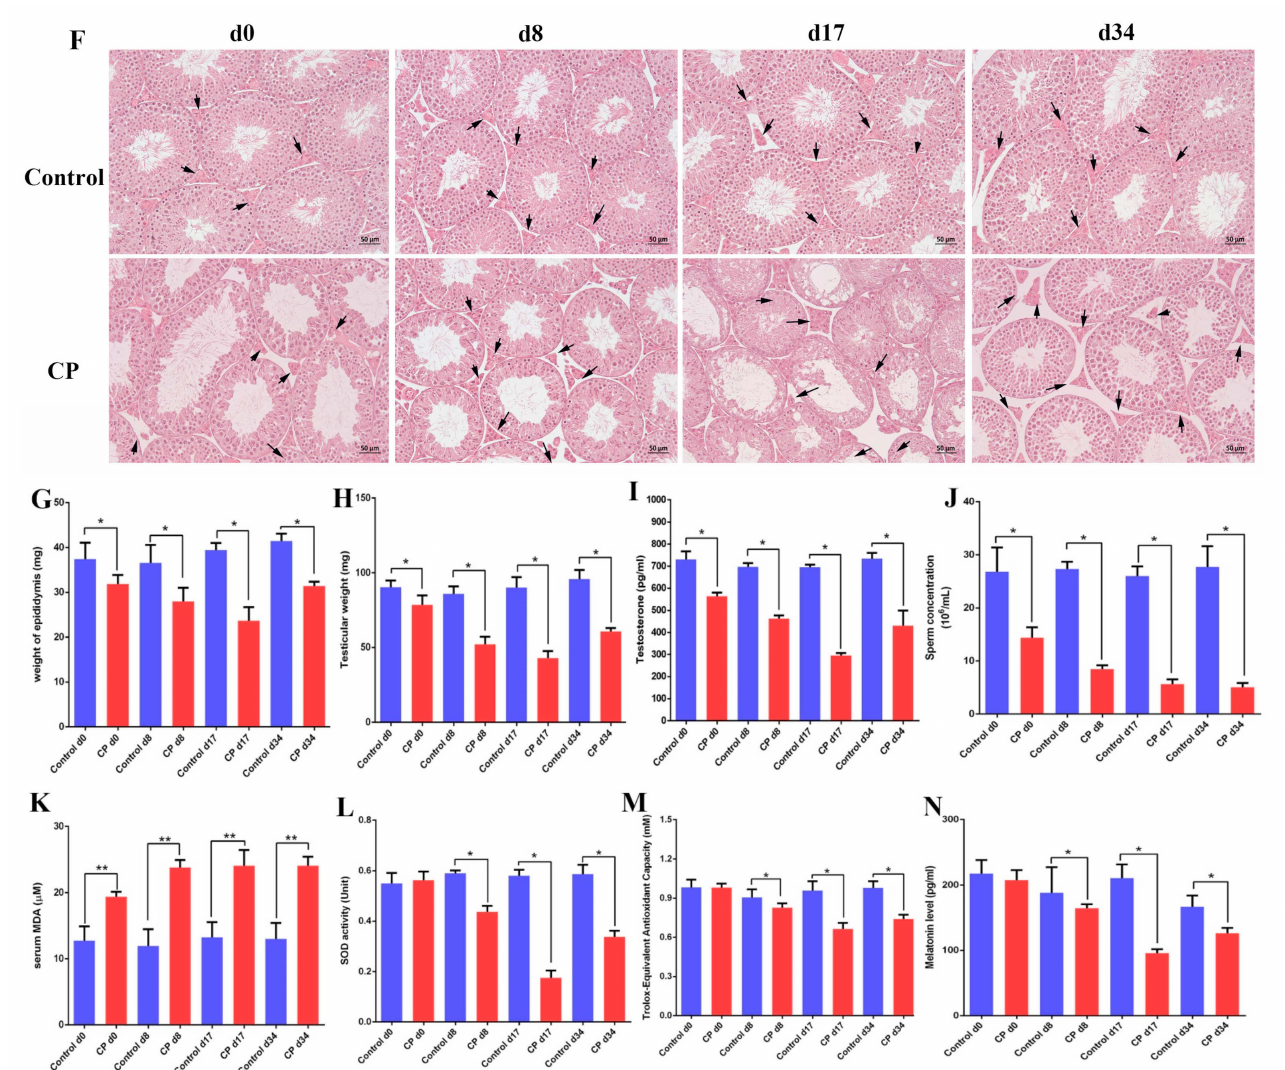
Figure 2. Cisplatin treatment resulted in damage to the testes of male mice and increased oxidative stress. ( A ) Experimental design. ( B ) Changes in the body weight of mice during different recovery periods after cisplatin treatment. ( C ) Images of mouse testes sizes. ( D ) Images of mouse epididymides sizes. ( E ) Mouse epididymides stained with H&E (scale bar = 50 µ m). ( F ) Mouse testicular cross sections stained with H&E (scale bar = 50 µ m). Arrows: Leydig cells of the testes. ( G ) Weight of mouse epididymides during different recovery periods after cisplatin treatment. ( H ) Mouse testicular weight during different recovery periods after cisplatin treatment. ( I ) Detection of the testosterone level in the mouse testes. ( J ) Epididymal sperm count. ( K ) Detection of serum MDA in mice. ( L ) Detection of serum SOD activity in mice. ( M ) Detection of serum total antioxidant capacity in mice. ( N ) Detection of the serum melatonin level in mice. CP, cisplatin. Data are presented as the mean ± SEM. N = 6 mice per group. * p < 0.05, ** p < 0.01 versus the control